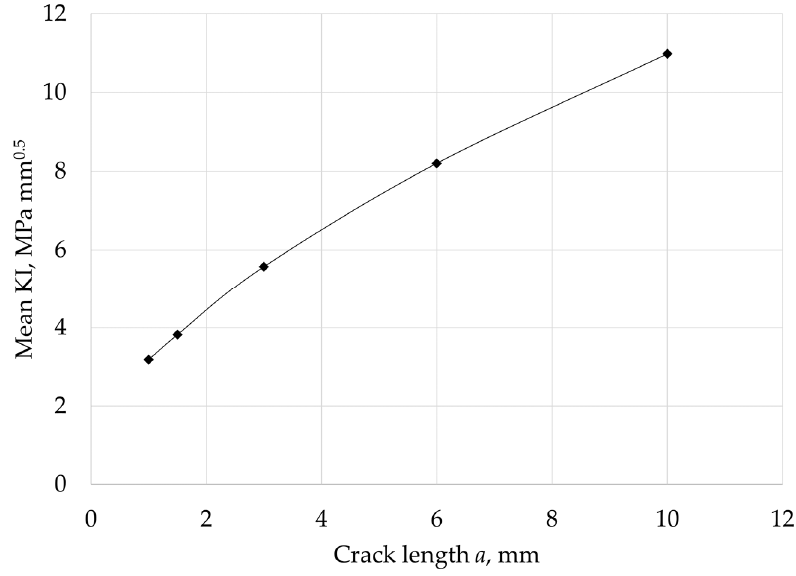
Figure 19. Evolution of 𝐾 (cid:3010) with the crack length 𝑎 of the test plate.